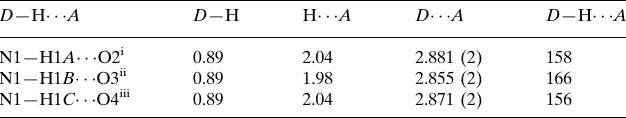
Hydrogen-bond geometry (A˚ , (cid:3)